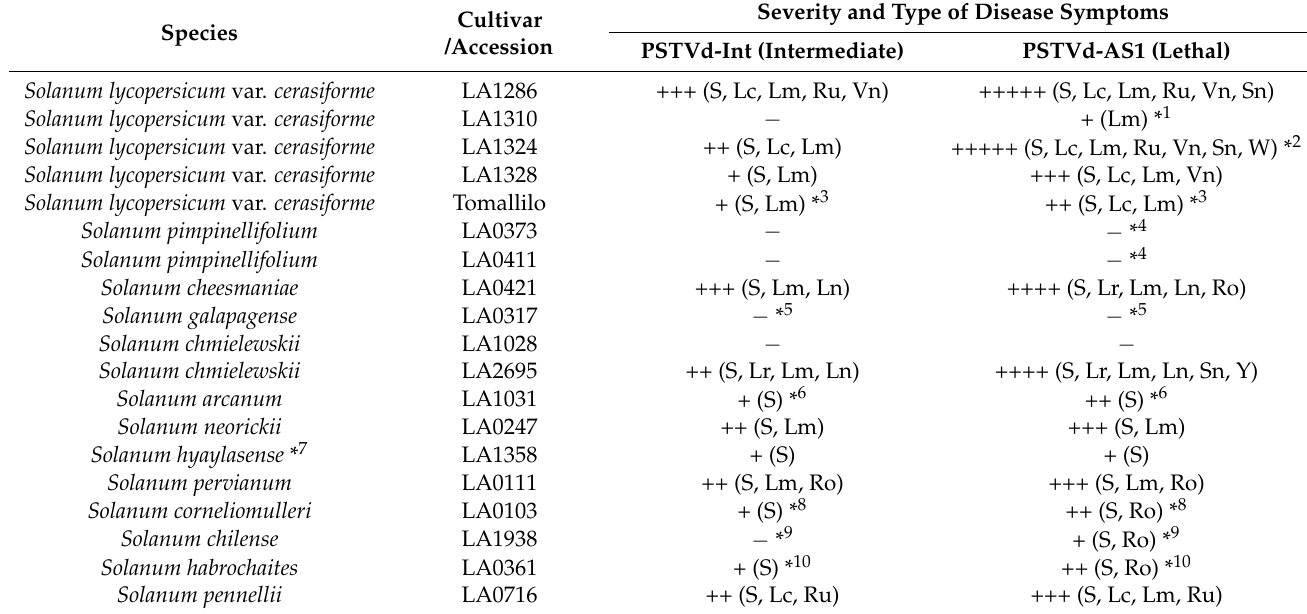
Table 2. Symptoms of wild tomatoes and wild tomato relatives infected with intermediate and lethal strains of PSTVd.